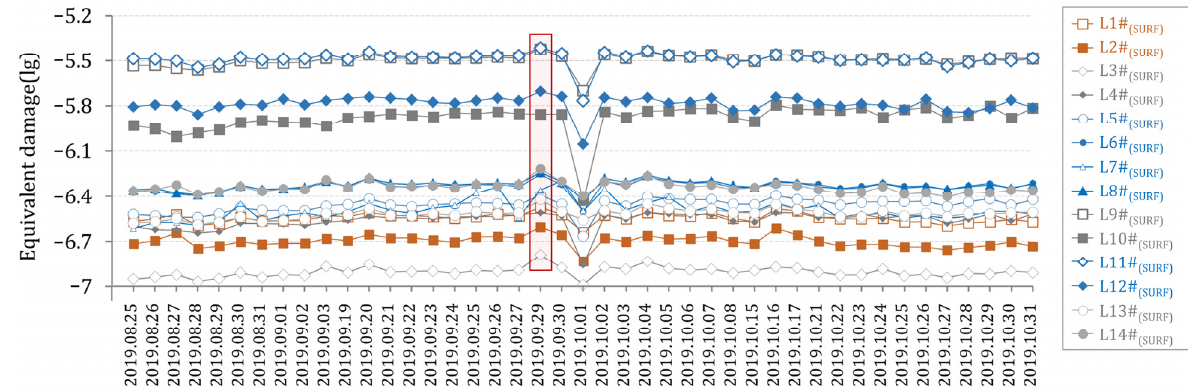
Figure 18. Equivalent damage during the test period.